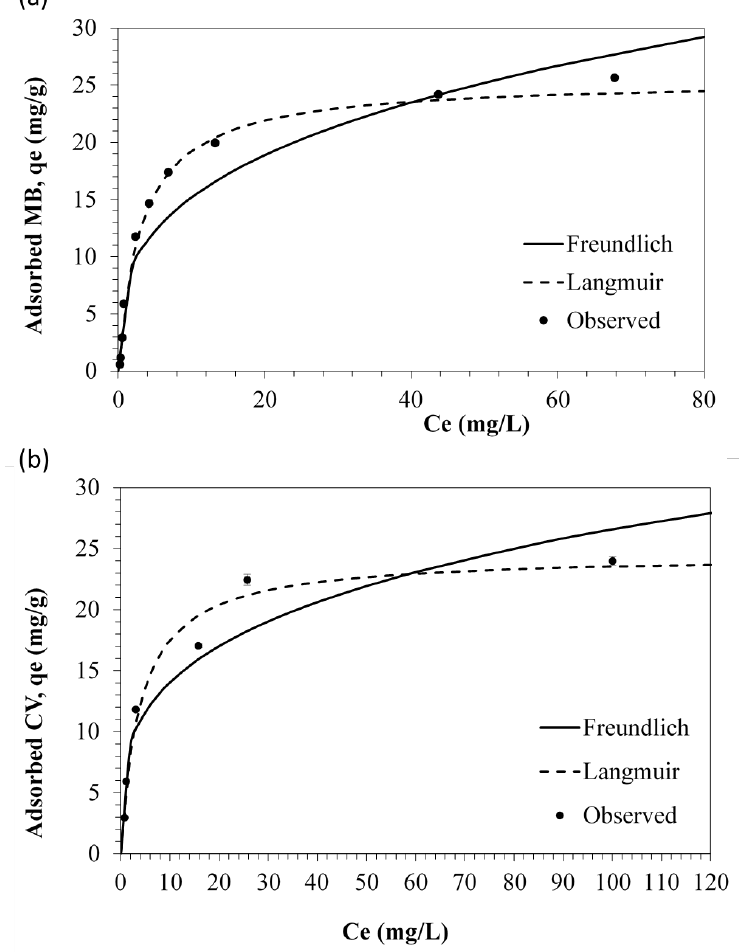
Figure 5. Freundlich and Langmuir adsorption isotherms using rice husk for ( a ) methylene blue (MB) and ( b ) crystal violet (CV). Table 2. Langmuir and Freundlich constants for adsorption of methylene blue (MB) and crystal violet (CV) onto rice husk. C e : the dye concentration in aqueous solution after reaction (mg/L); K L : Langmuir adsorption constant (L/mg); Q m : maximum adsorption amount of dye per unit mass of RH (mg/g); K F : distribution coefficient (L/g); n : Freundlich constant.